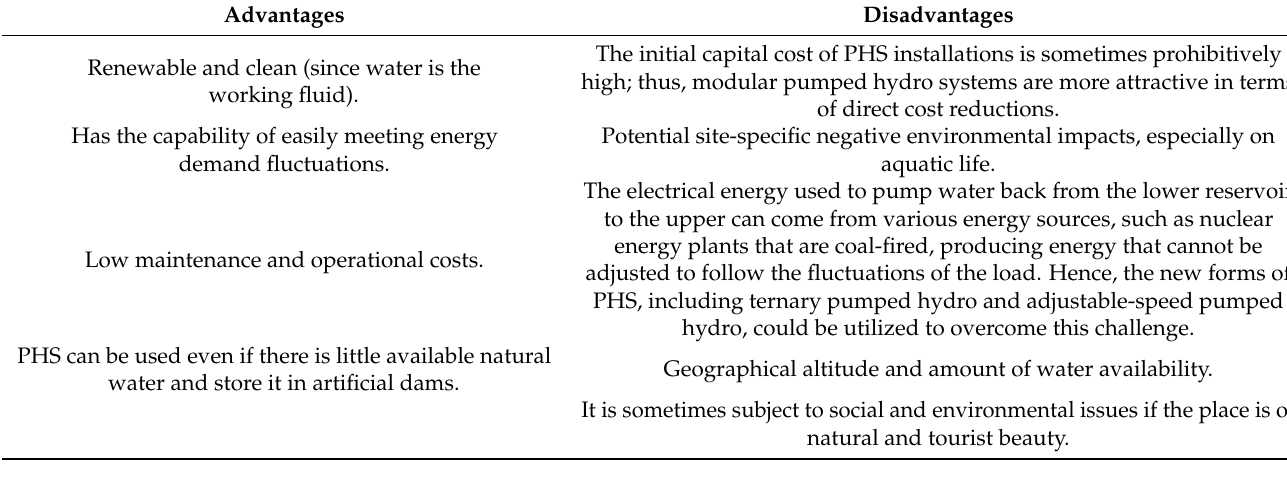
Table 1. Advantages and disadvantages of